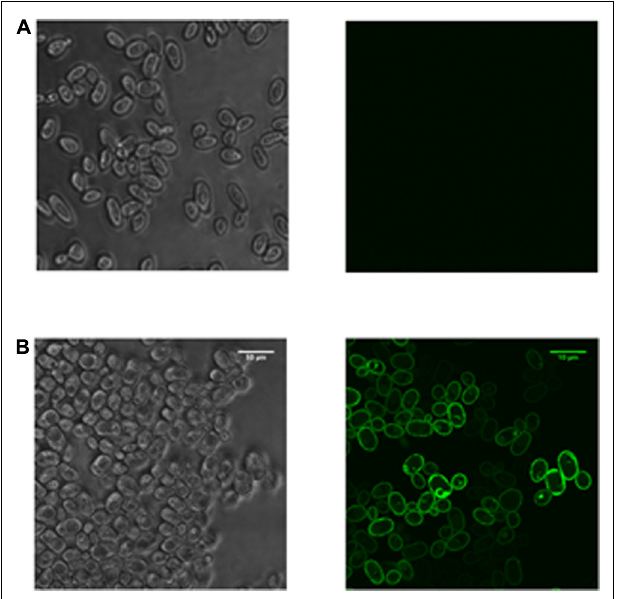
FIGURE 1 | Strain selection enables the production of a human membrane protein in S. cerevisiae. Yeast cells were transformed with a plasmid expressing a construct encoding a human membrane protein tagged with green fluorescent protein. Expression was driven from a constitutive promoter and cells were imaged using confocal microscopy with an upright LeicaTCS SP5 system.The sample was excited with a visible argon laser at 488 nm and imaged using a 63 × oil objective.The panels show confocal images with bright-field and fluorescence for (A) wild-type cells and (B) a mutant S. cerevisiae strain selected from a global screen for high yielding strains (Bonander etal., 2005). Only the mutant cells produced correctly localized